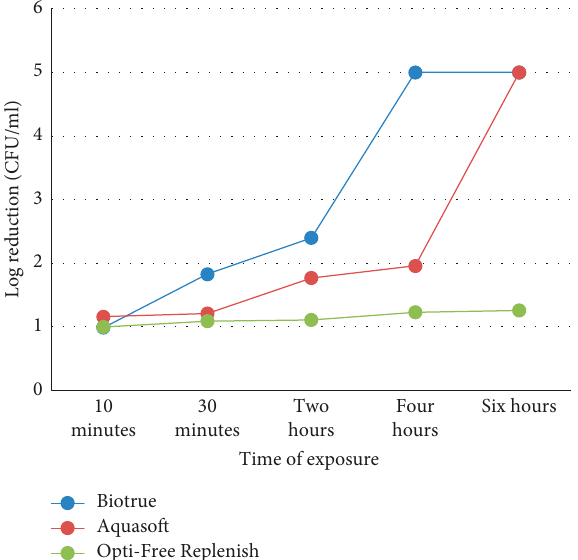
Figure 2: Effects of different MPS and length of exposure on the concentration of Pseudomonas